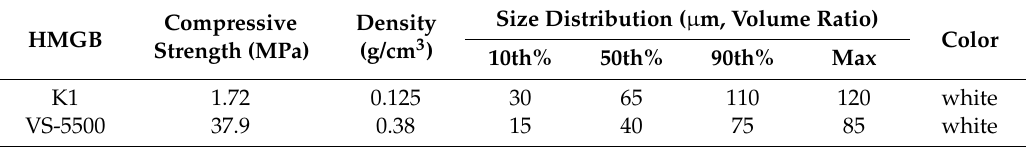
Table 2. Main performance parameters of HMGB K1 and HMGB VS-5500.